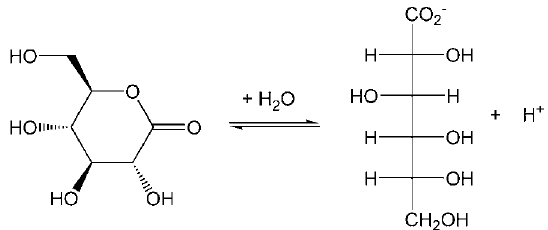
Figure 3 SMP30 catalyzes the interconversion of D -glucono- d - lactone and D -gluconic acid in the presence of divalent cations, including Mn 2 q , Mg 2 q , Ca 2 q , and Zn 2 q